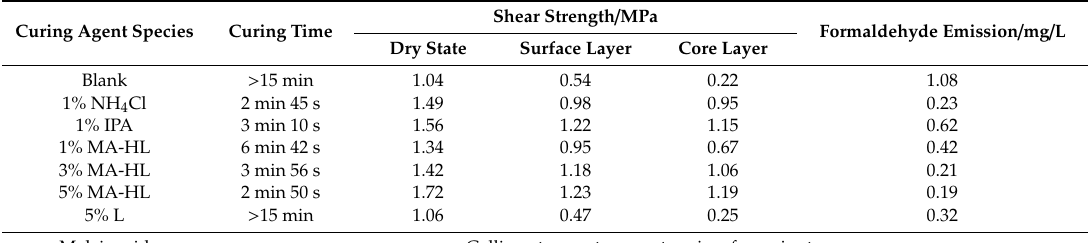
Table 1. Curing time, shear strength, and formaldehyde release of UF resins with different curing agents.